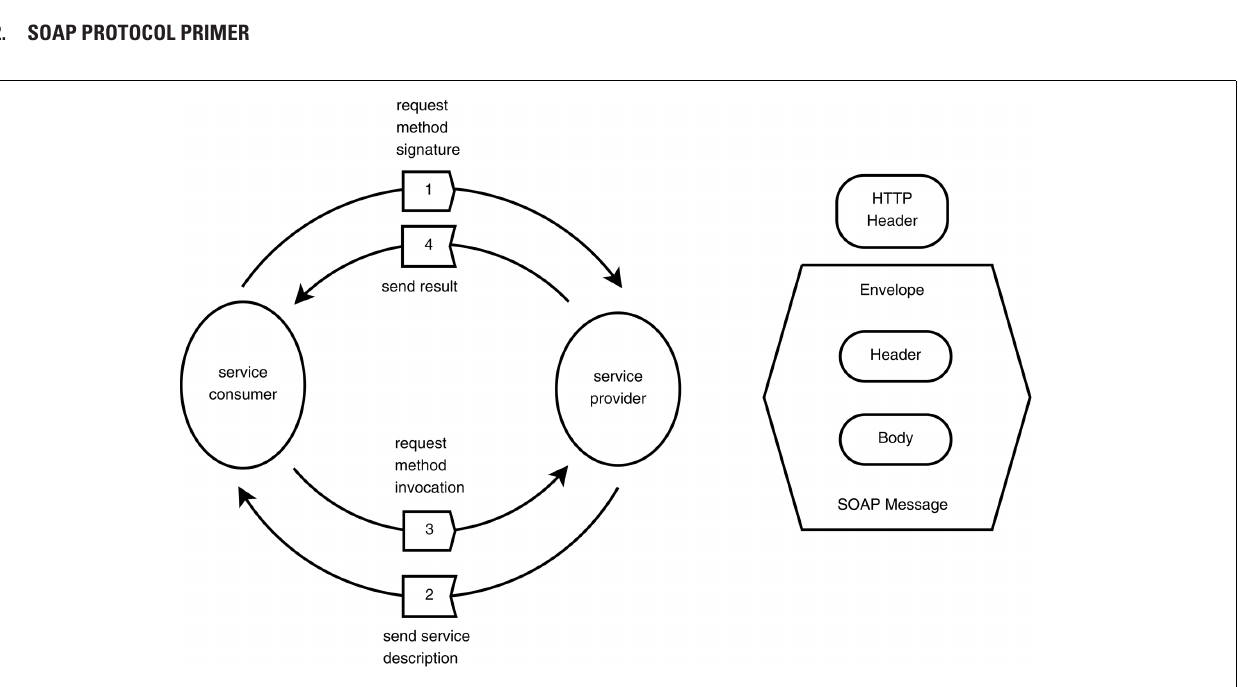
FIGUREA4 |The SOAP protocol. Interaction between the service consumer and the service provider (top). Elements of the SOAP message over HTTP